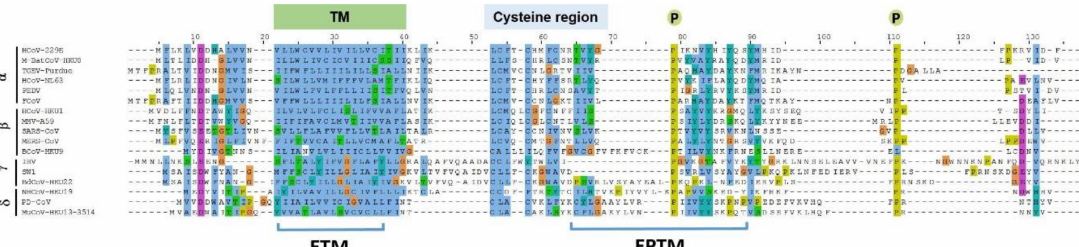
Figure 1. Multiple sequence alignment of coronavirus E protein. Alignment was done using Jalview 2.9.0b2 and the position of key features, TM, EPTM, Cys region and conserved prolines indicated. Four genera of coronavirus are represented as follows: α -CoV is represented by HCOV-229E, Human coronavirus 229E (NP_073554.1); M-BatCoV-HKU8, Miniopterus bat coronavirus Hong Kong University 8 (YP_001718614.1); TGEV-Purdue, transmissible gastroenteritis virus-Purdue (ABG89336.1); HCoV-NL63, Human coronavirus NL63 (YP_003769.1); PEDV, Porcine epidemic diarrhea virus (NP_598312.1); FCoV, Feline coronavirus (YP_004070197.1); β -CoV include HCoV-HKU1, Human coronavirus Hong Kong University 1(YP_173240.1); MHV-A59, Murine hepatitis virus-A59 (NP_068673.1); SARS-CoV, Severe acute respiratory syndrome coronavirus (NP_828854.1); MERS-CoV, Middle East respiratory syndrome coronavirus (YP_009047209.1); BCoV-HKU9, Bat coronavirus Hong Kong University 9 (YP_001039973.1); γ -CoV include IBV, Infectious bronchitis virus (ADP06512.1); SW1, sperm Whale coronavirus 1(YP_001876438.1); BdCoV-HKU22, Bottlenose dolphin coronavirus Hong Kong University 22 (AHB63482.1); δ -CoV consists of NHCoV-HKU19, Night-heron-coronavirus- Hong Kong University 19 (AFD29227.1); PD-CoV, Porcine coronavirus Hong Kong University 15 (YP_005352832.1); MCoV-HKU13, Munia coronavirus Hong Kong University 13-3514(YP_002308507.1). TM: transmembrane domain; highly conserved cysteine residues indicated; conserved proline indicated by stars. Blue represents hydrophobic amino acids (A, I, L, M, F, W, V); Red represents positive charge amino acids (K, R); Magenta represents negative charge amino acids (E, D); Green represents polar amino acids (N, Q, S, T); Pink represents cysteines (C); Orange represents glycines (G); Yellow represents prolines (P); Cyan represents aromatic amino acids (H, Y); White represents any unconserved / gap. The SARS-CoV-2 E protein is 95% identical to SARS E, so was not included as a distinct